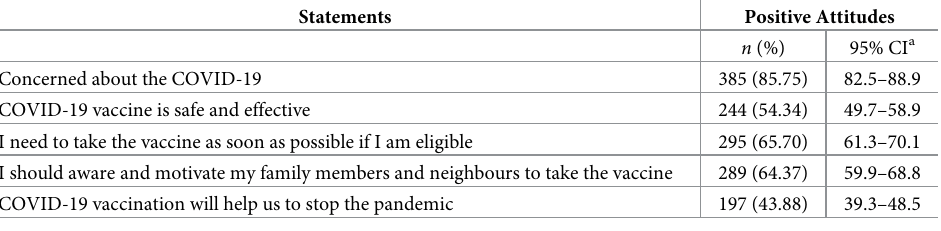
Table 4. Attitude towards COVID-19 vaccination ( n =